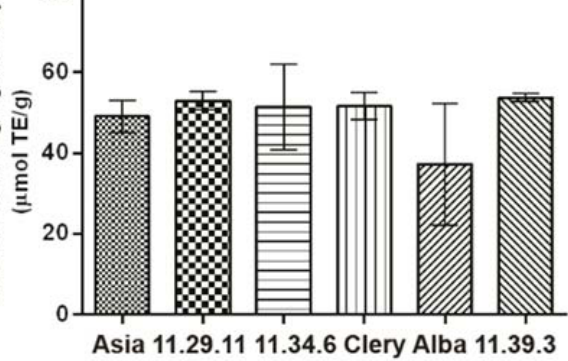
Figure 3. Mean total phenolic content and radical scavenging activity of six sorts of strawberry cultivars.